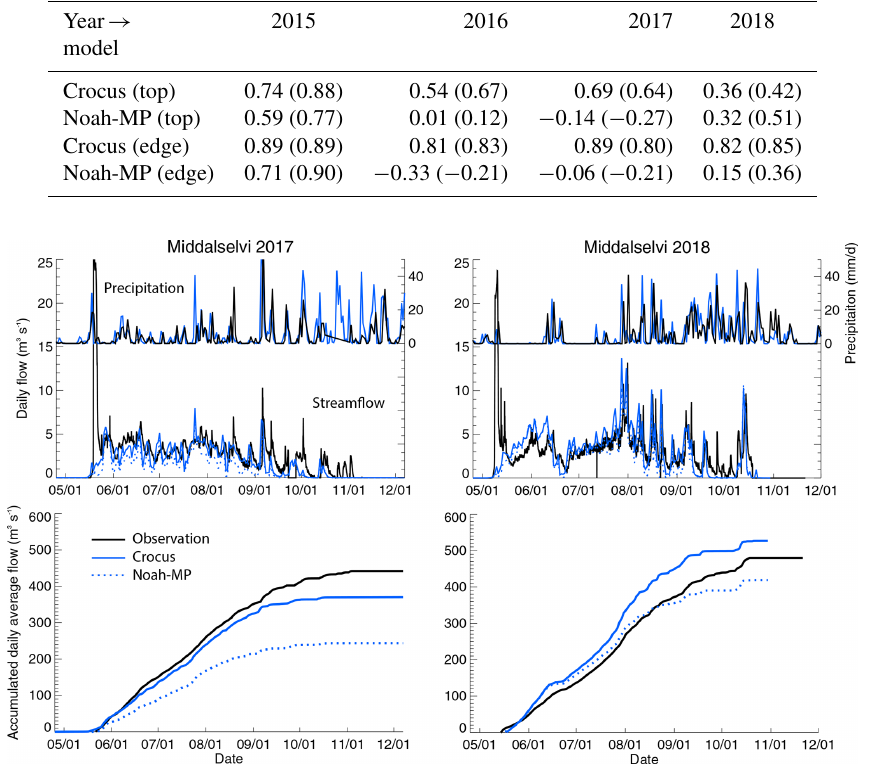
Figure 16. The top panels show the observed (black line) and modeled (blue) precipitation at the Finse AWS station and daily discharge at Middalselvi. The bottom panels show the accumulated discharge. The solid blue line refers to Crocus, and the dashed blue line refers to